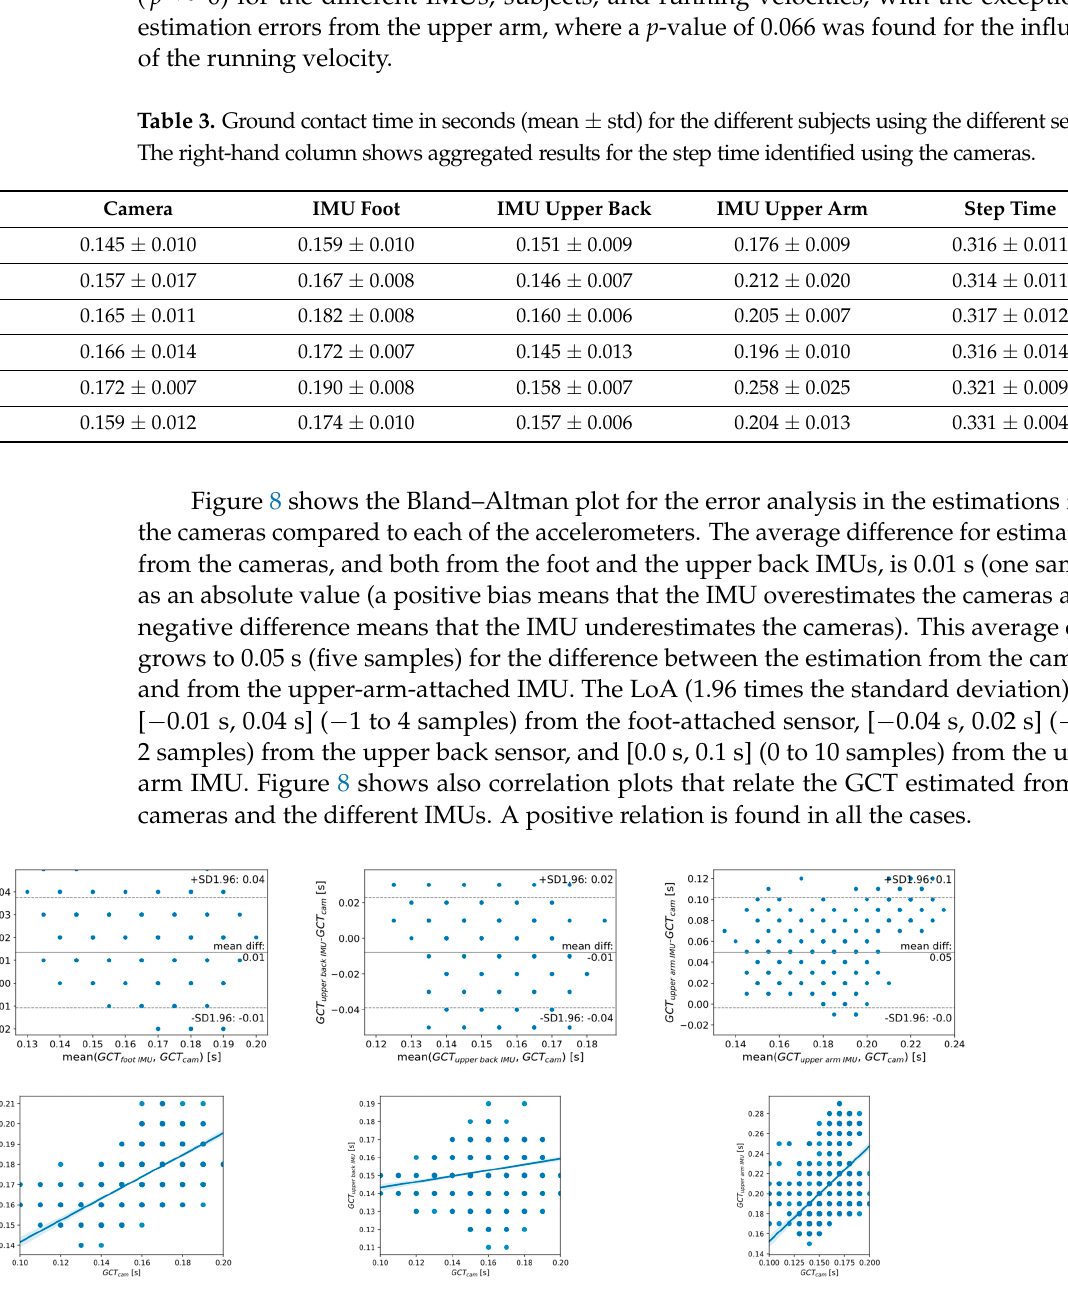
Figure 8. Top . Bland–Altman plot for the error in the estimation of GCT from the cameras and from the IMUs: foot-attached ( left ), upper-back-attached ( center ) and upper-arm-attached ( right ). The paired difference between the GCT estimations from the IMUs and the cameras are plotted against their mean for all the steps in the experiments. Mean difference in the GCT estimation between the IMU and the cameras is plotted with a central continuous straight line. 95% limits of agreement (1.96 times the standard deviation of the estimation errors) are plotted with upper and lower dashed straight lines. Bottom . Correlation plots. X -axis shows the GCT estimated from the cameras. Y -axis shows the corresponding GCT estimated from the IMUs attached to the foot ( left ), upper back ( center ), and upper arm ( right ).